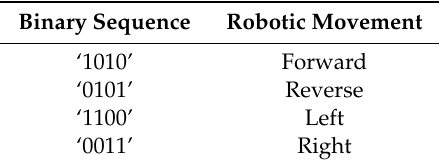
Table 1. Binary sequences with corresponding robotic